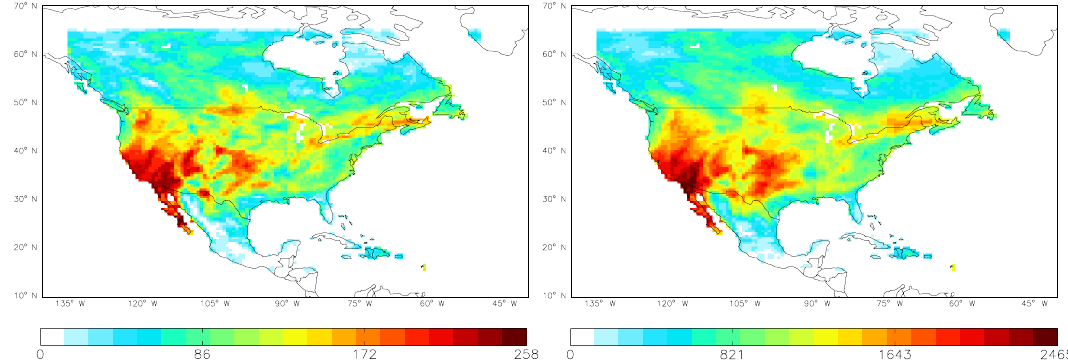
Figure 3. Density of satellite observations (gridcell − 1 week − 1 ) for LEO (left) and GEO (right) orbits for the nested North America domain (0 . 5 ◦ × 0 . 7 ◦ ) and for the period 1–8 July